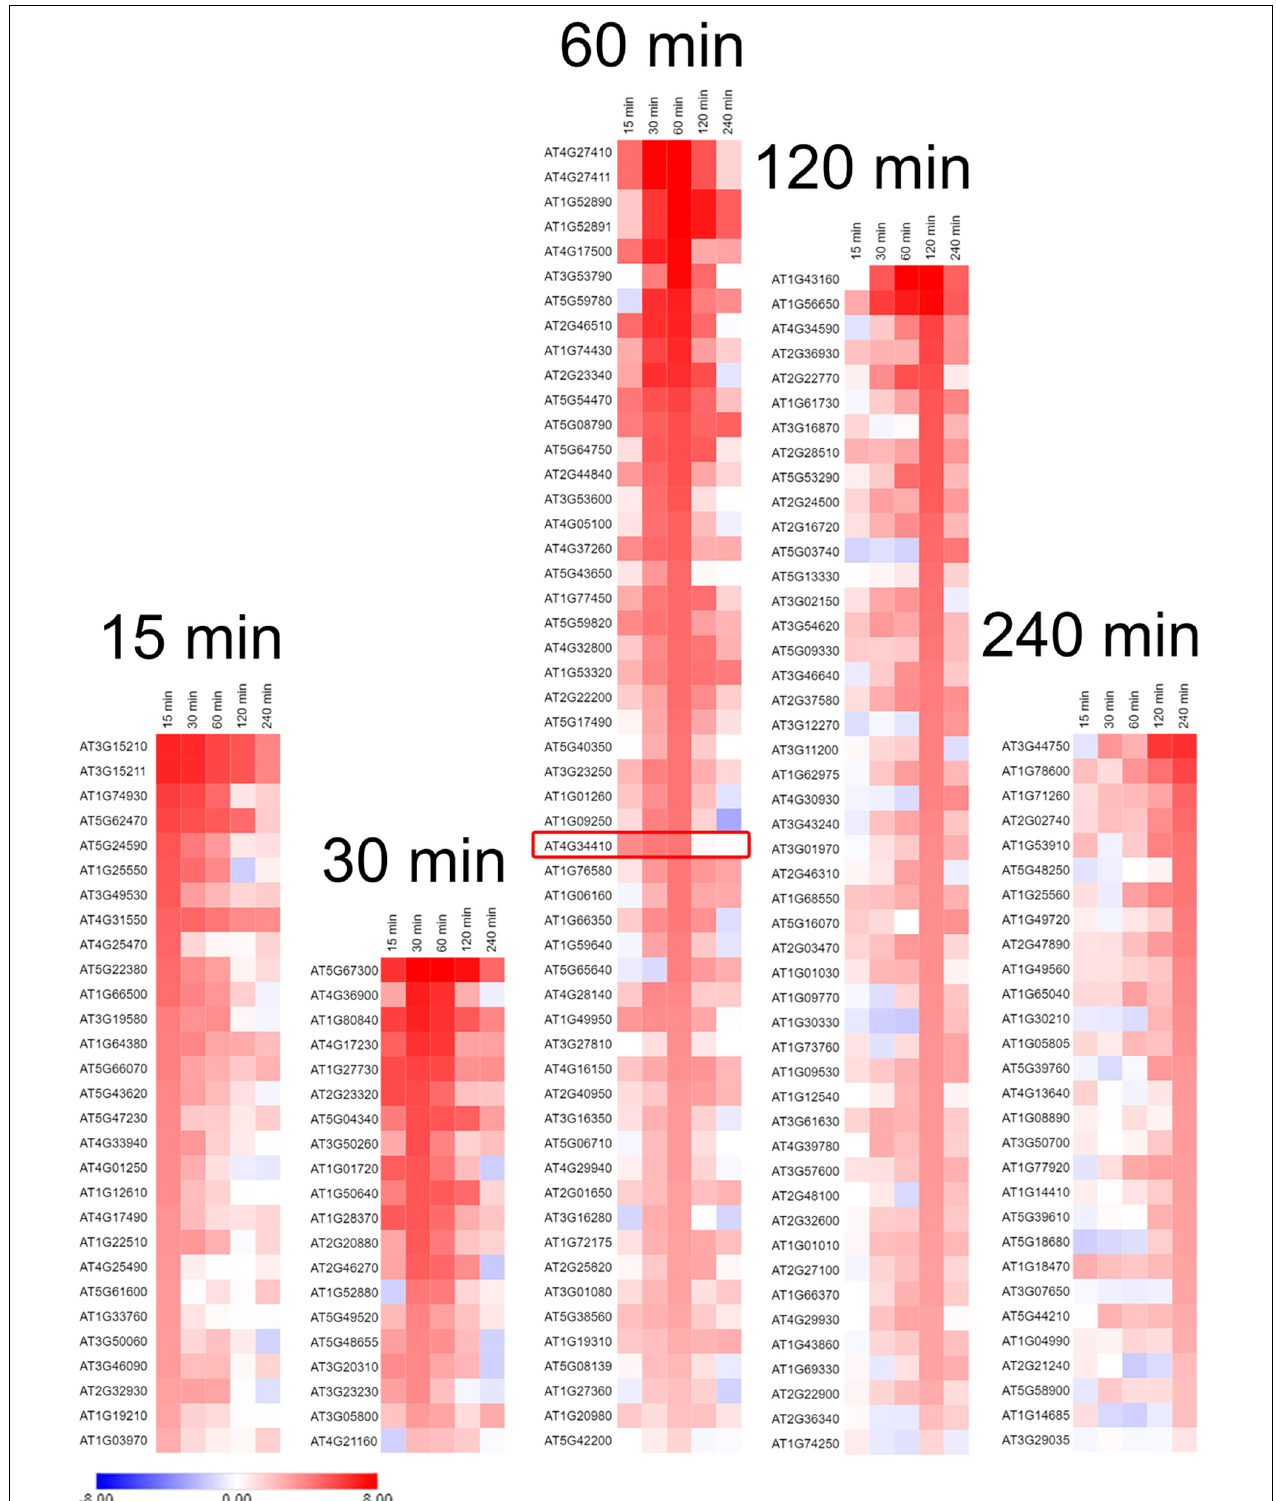
FIGURE 6 | Transcription factors in Col-0 whose expression was increased in response to an increase in PFD from 120 to 500 µ mol m − 2 s − 1 . Transcription factors are grouped according to the time they had the highest transcript abundance after transfer to high light. The red box is around the RRTF1 transcription factor. Expression values used for heat map generation are the log 2 (cid:49) RPKM + 1 and are on an absolute scale of –8 to 8. n = 3.